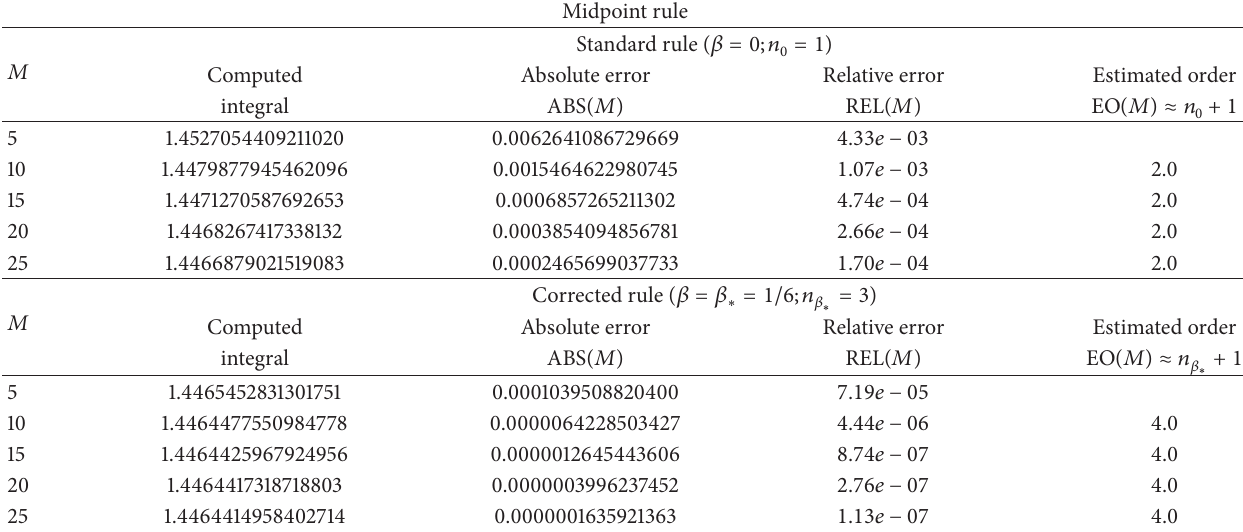
Table 4: Results for the midpoint rule.